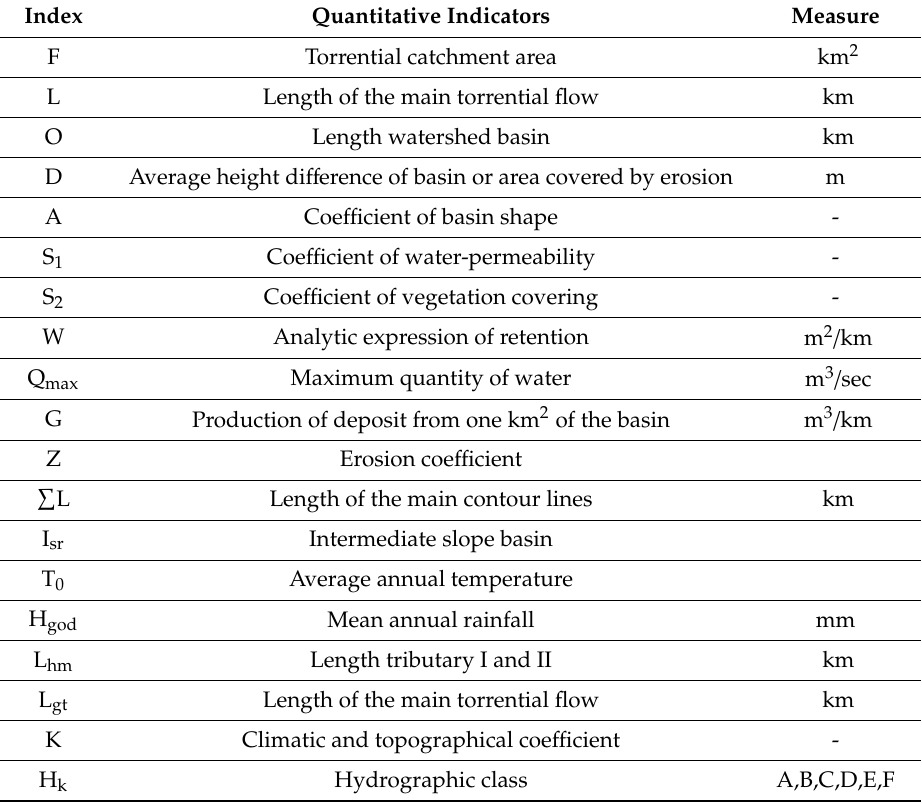
Table A1. Quantitative indicators of the Gavrilovi´c